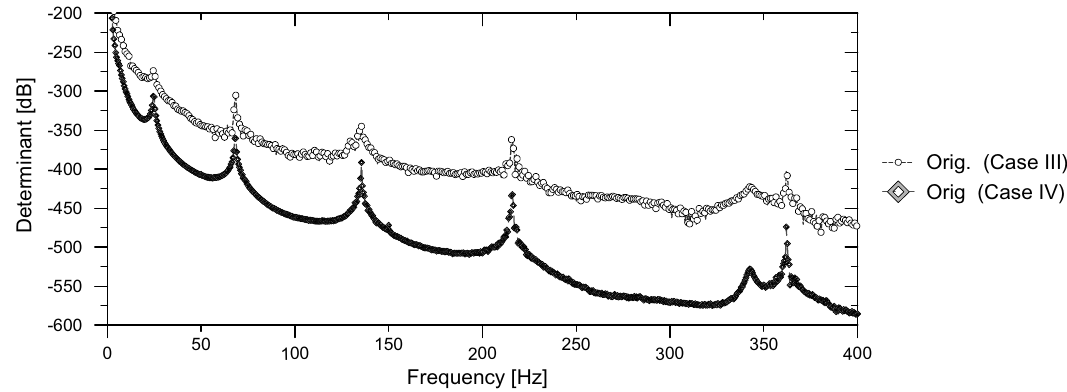
Fig. 17. Determinant curves of matrix H KA for case study III and H T KA · H KA for case study IV.